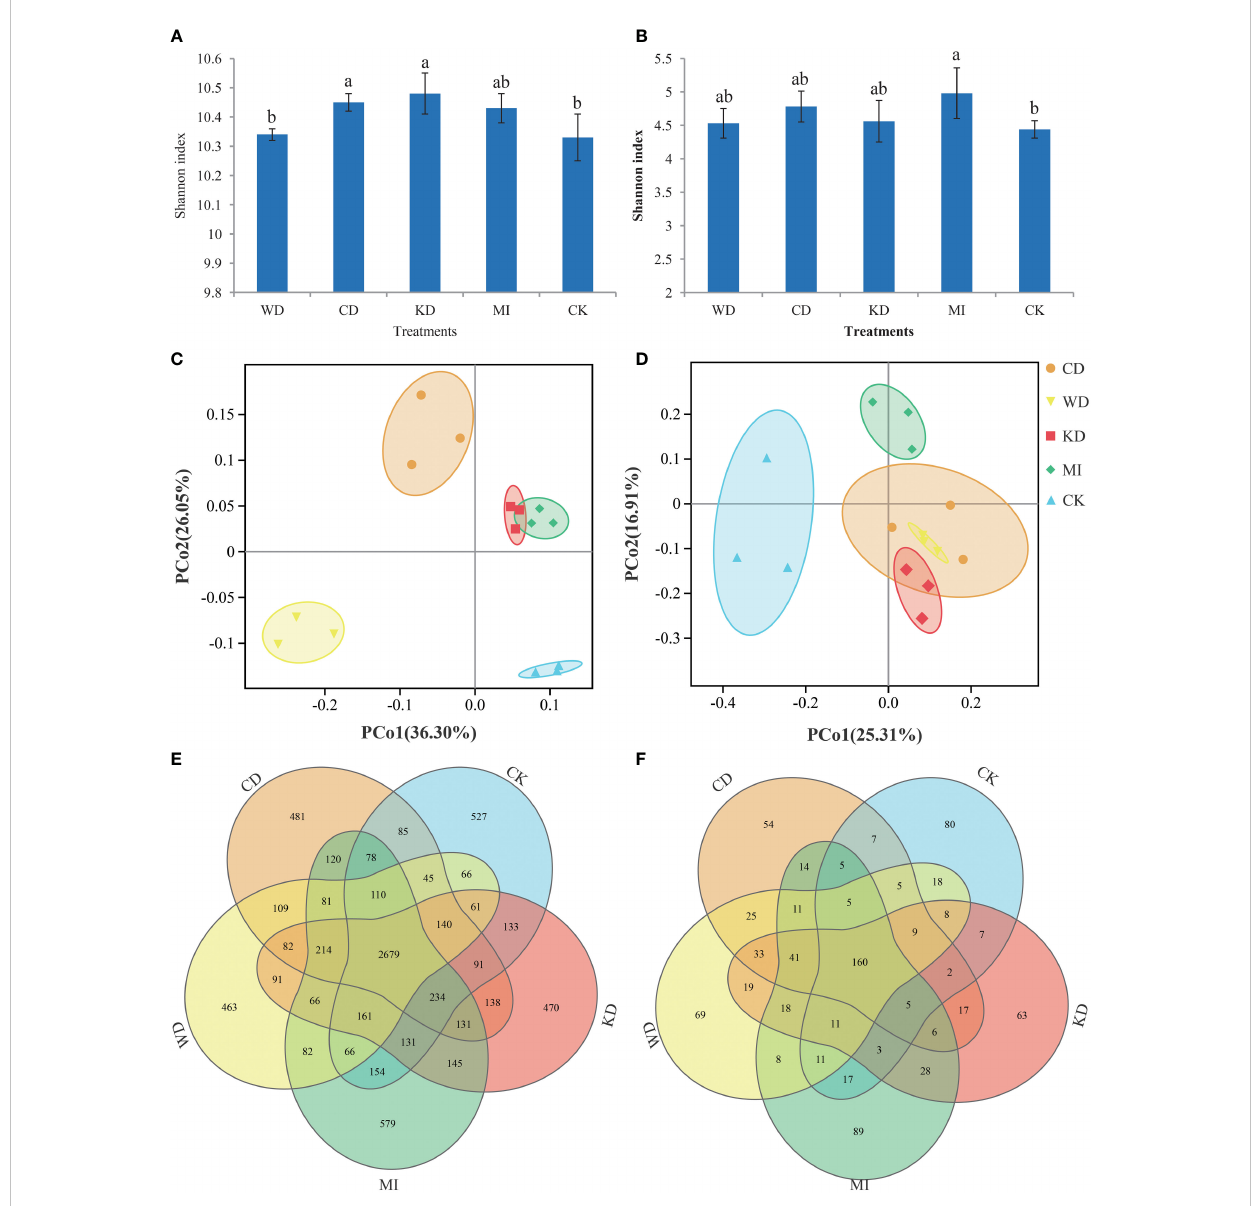
FIGURE 1 Microbial community diversity in different intercropping modes. Shannon index diversity of bacteria (A) and fungi (B) communities under different treatments. A lowercase letter on each box represents a least signi fi cant difference (LSD; p < 0.05) between treatments. Principal coordinate analysis (PCoA) plots based on the Bray-Curtis distance demonstrating the separation between soil bacteria (C) and fungi (D) communities of different treatments. The Venn diagram shows the numbers of bacteria (E) and fungi (F) operational taxonomic units (OTUs) that are shared or unshared by different treatments. WD, watermelon-daylily intercropping; CD, cabbage-daylily intercropping; KD, kale-daylily intercropping; MI, row mixed intercropping, watermelon, cabbage, and kale were alternately intercropped with daylily; CK, monoculture